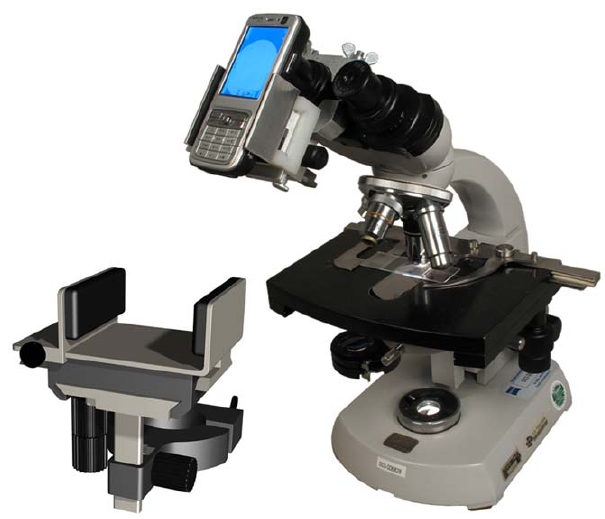
Figure 1. The prototype connector which attaches a mobile phone to a microscope. The prototype connector was designed by TU Delft and TNO. The connector is adjustable to fit all sizes of candy bar phones and some slide phones. It also consists of adjustable screws to fit most regular light microscopes.